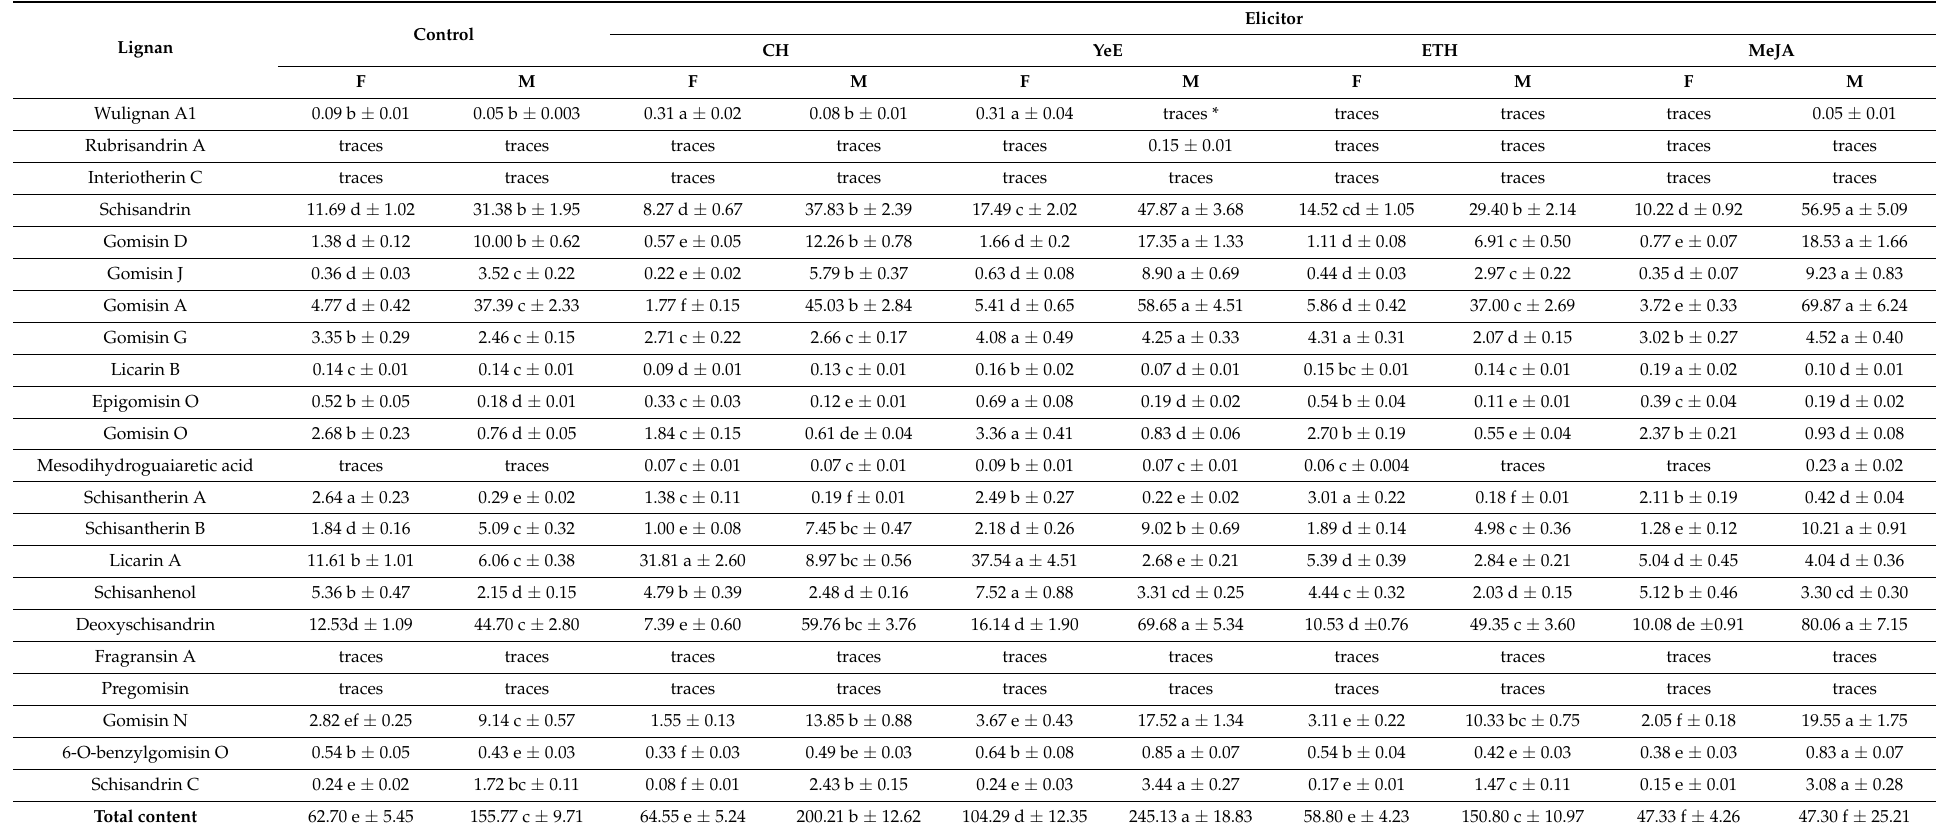
Table 6. Accumulation of lignans (mg/100 g DW) in agitated cultures of S. rubriflora lines F and M 8 days after addition of elicitor. Data expressed as the